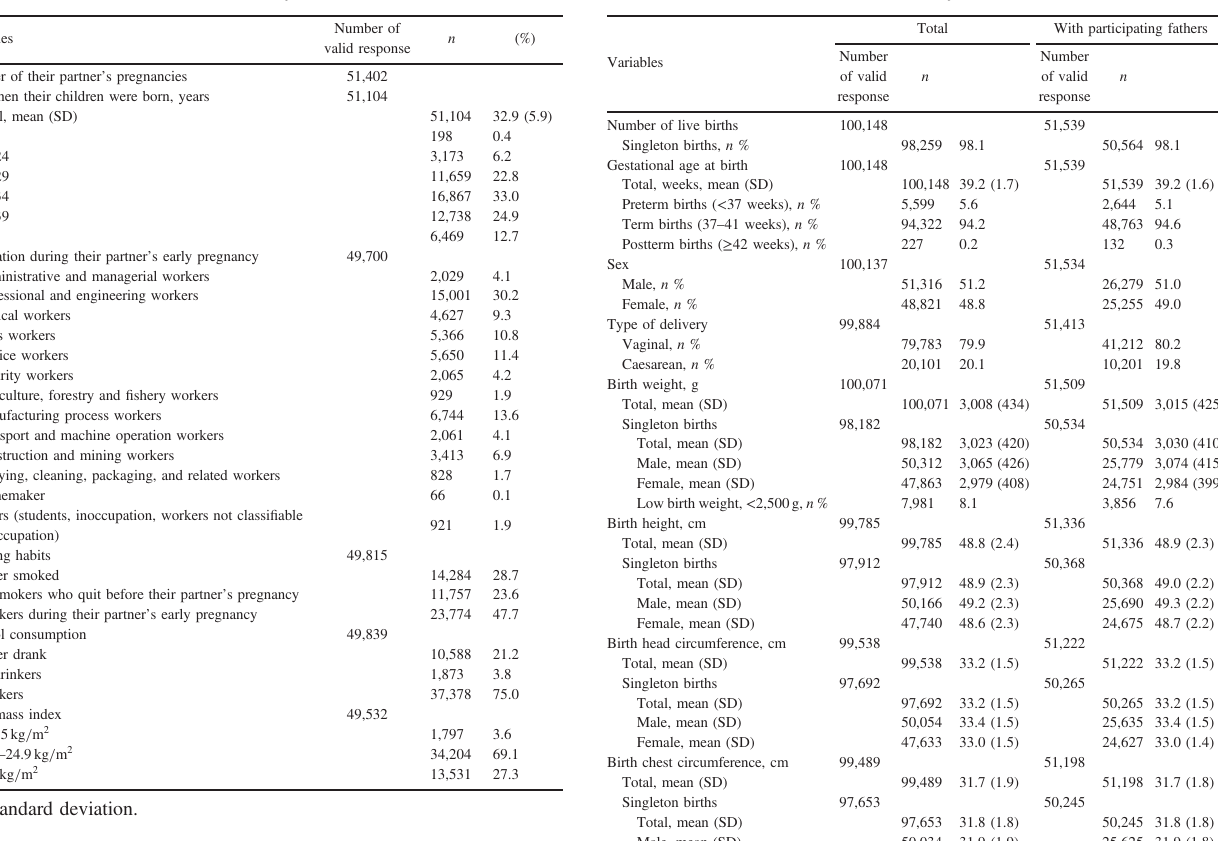
Table 4. Baseline pro fi les of the children in the Japan Environ- ment and Children ’ s Study, 2011 – 2014 Total With participating fathers Number Number Variables n of valid of valid response response